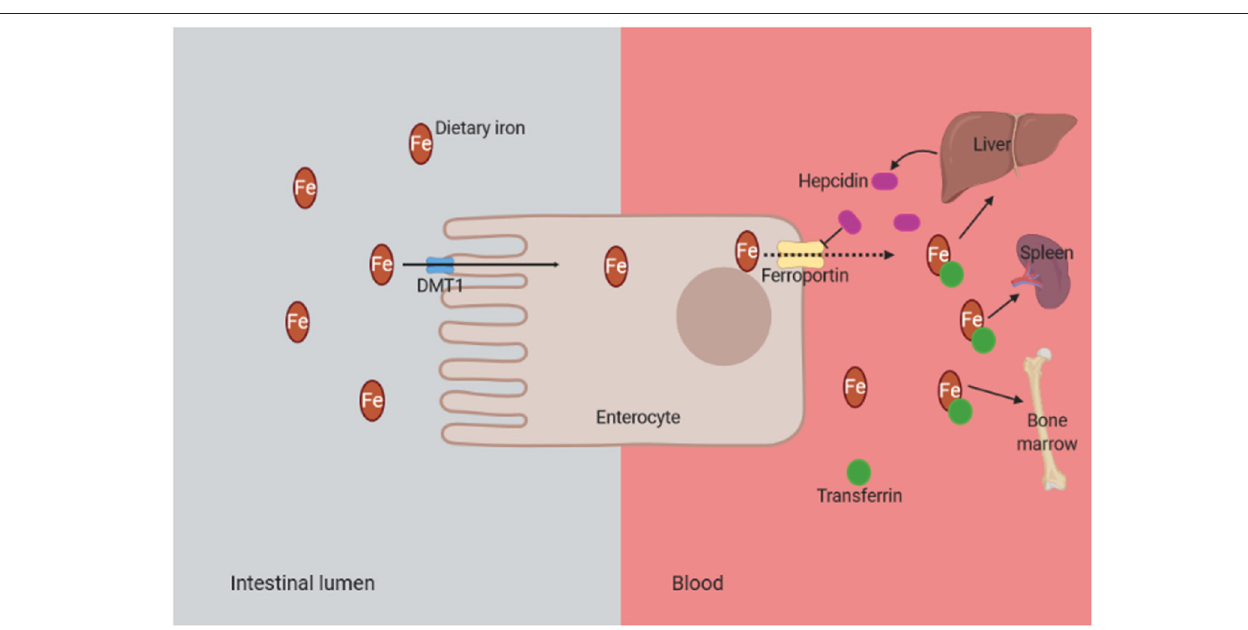
FIGURE 5 | Mechanism of functional iron deficiency anemia in CKD. The presence of chronic inflammation in CKD is associated with overproduction of hepcidin due to inflammatory cytokines such as interleukin-6. Consequently, the hepcidin binds to the iron transporter ferroportin and prevents the dietary iron transport into the circulation. DMT1, divalent metal transporter 1 (it is strongly expressed at the apical brush border of enterocytes, allowing the entry of ferrous iron from the intestinal lumen into cells); CKD, chronic kidney disease.